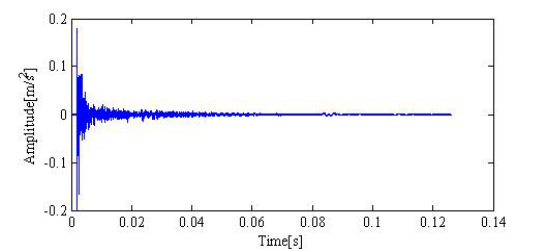
Fig. 6. Time domain waveforms of level III